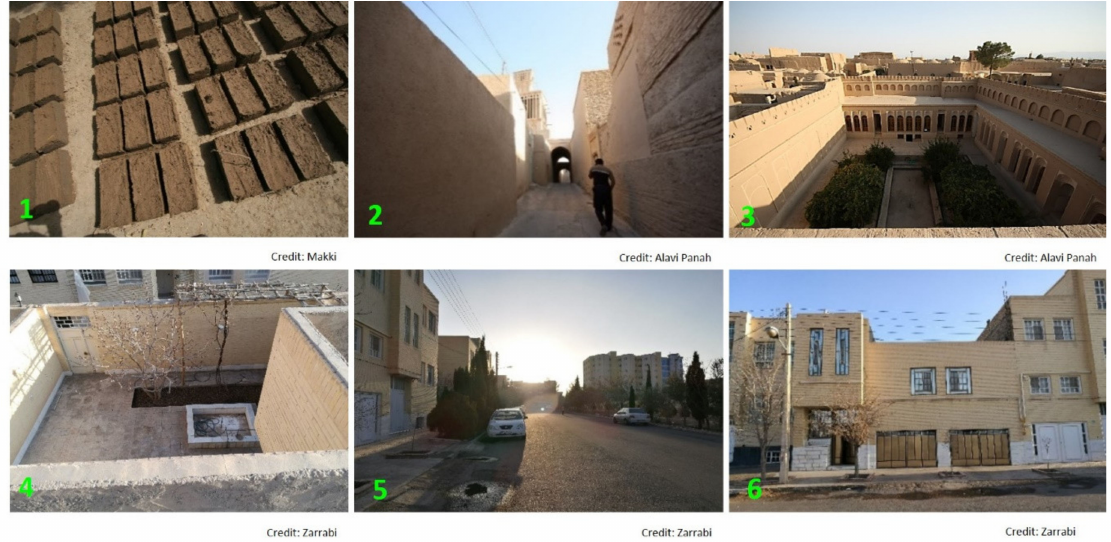
Figure 2. The physical morphology of the buildings in the historical district and the new district. Pictures 1 – 3 show the historical district, and pictures 4 – 6 show the new district of the city of Yazd. Picture 1 was taken by Mohsen Maki, pictures 2 and 3 were taken by Alavi Panah and pictures 4 – 6 were taken by Amirmasoud